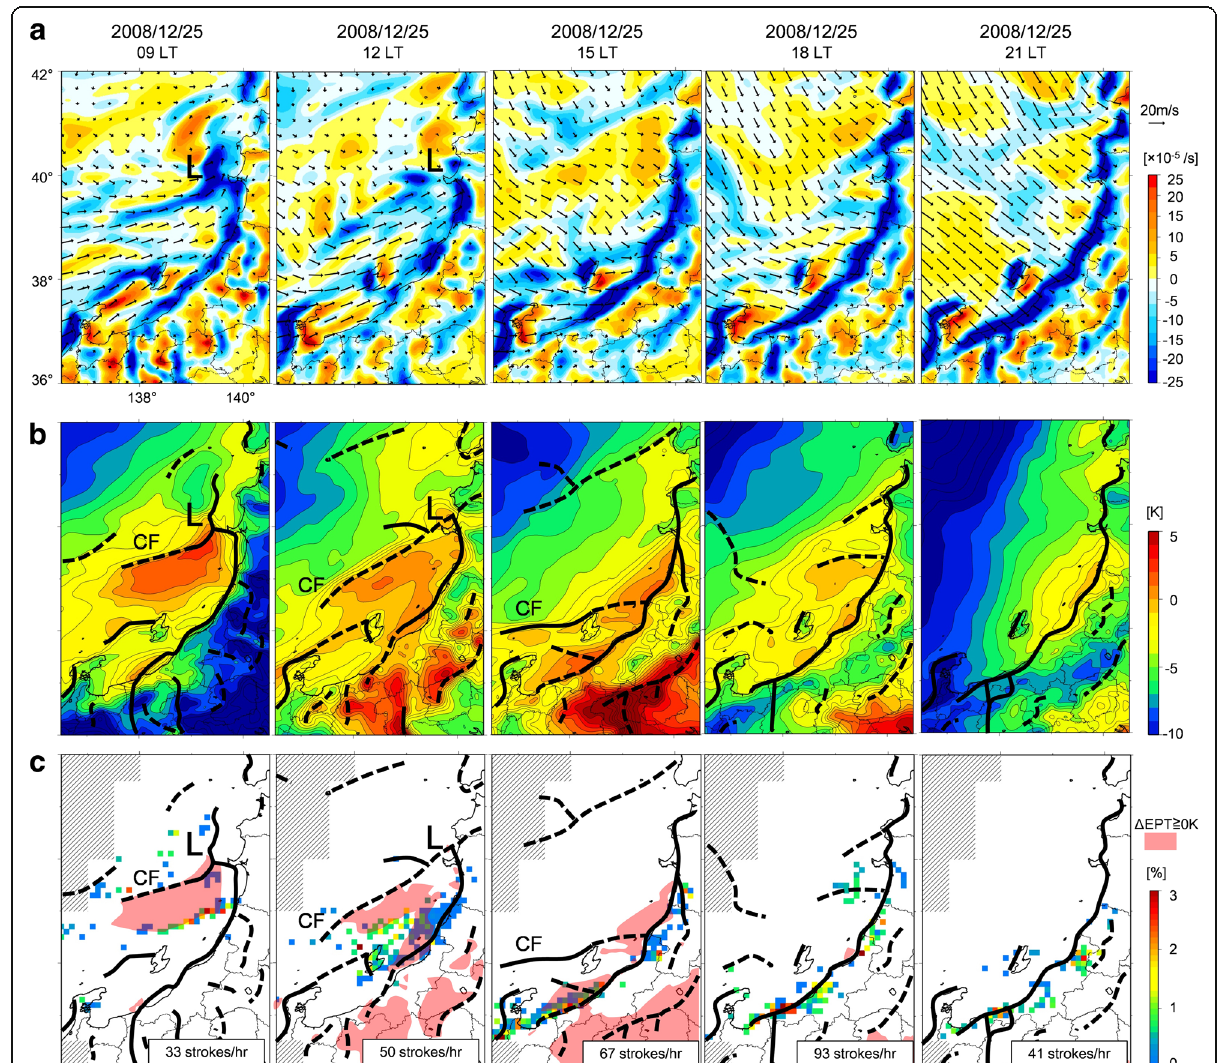
Fig. 14 a – c Similar to Fig. 11 but for case B. “ L ” represents the center of the